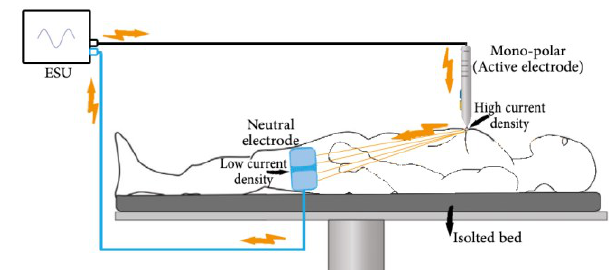
Fig. 1 : Mono - polar ESU Modes.